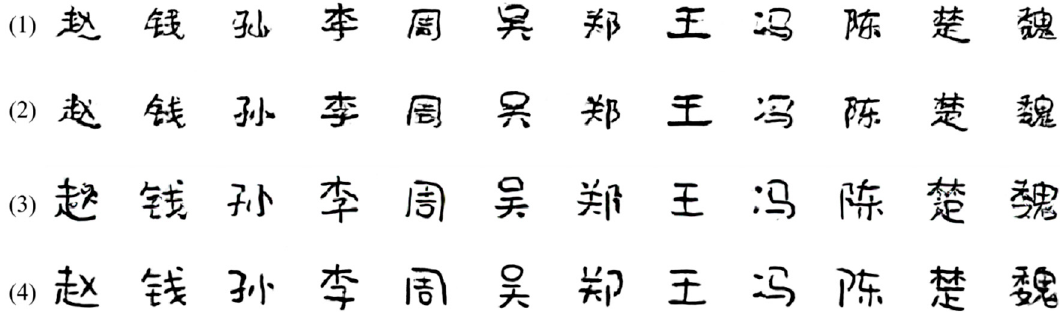
Figure 11. The comparison results of fonts generated by our models. The images of the first and second rows are the characters of Font 9, and the third and fourth rows are of Font 6. The models used to generate the images of the first to fourth rows are EG-GAN 1,2 , EG-GAN 1 , EG-GAN 2 and EG-GAN, respectively.